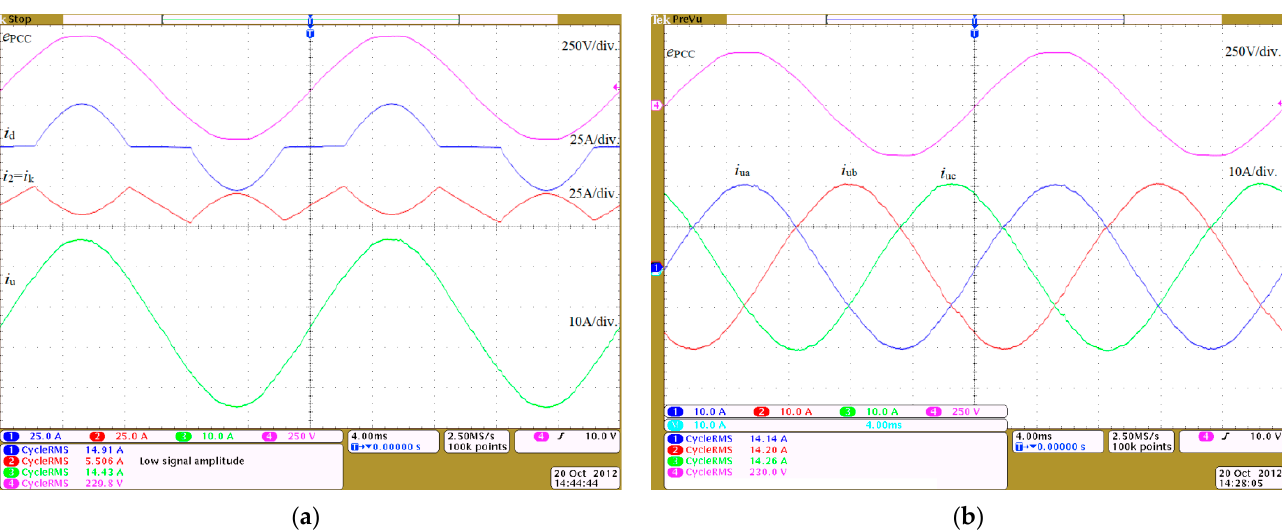
Figure 6. Oscillograms of the following waveforms: ( a ) from the top: voltage in the PCC, downstream current, APF cur- rent, upstream current in the PCC; ( b ) from the top: voltage in the PCC, three phases of the upstream current in the PCC.